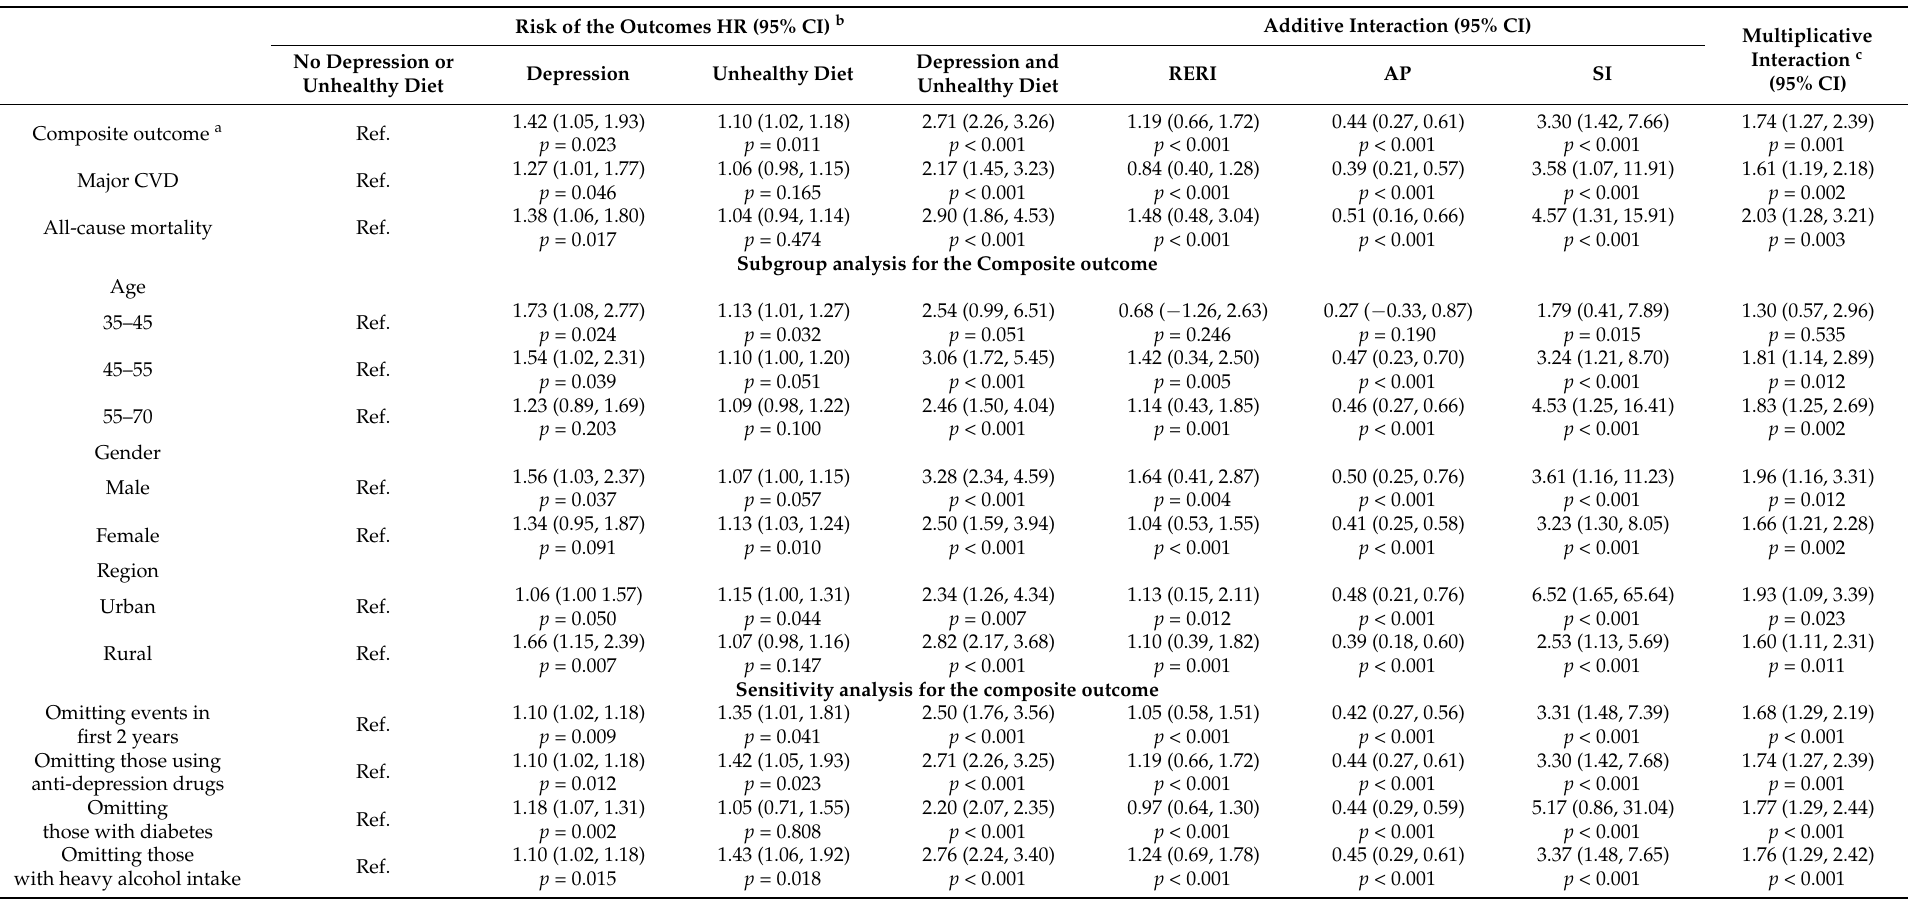
Table 3. Interaction of depression and unhealthy diet for the